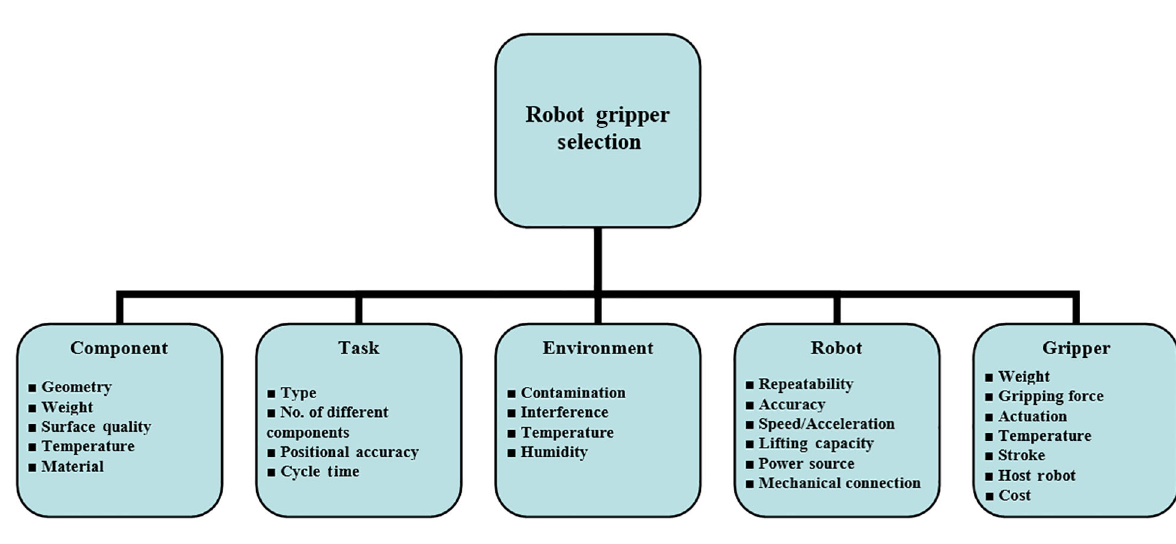
Fig. 5. Governing factors for gripper selection (adapted from